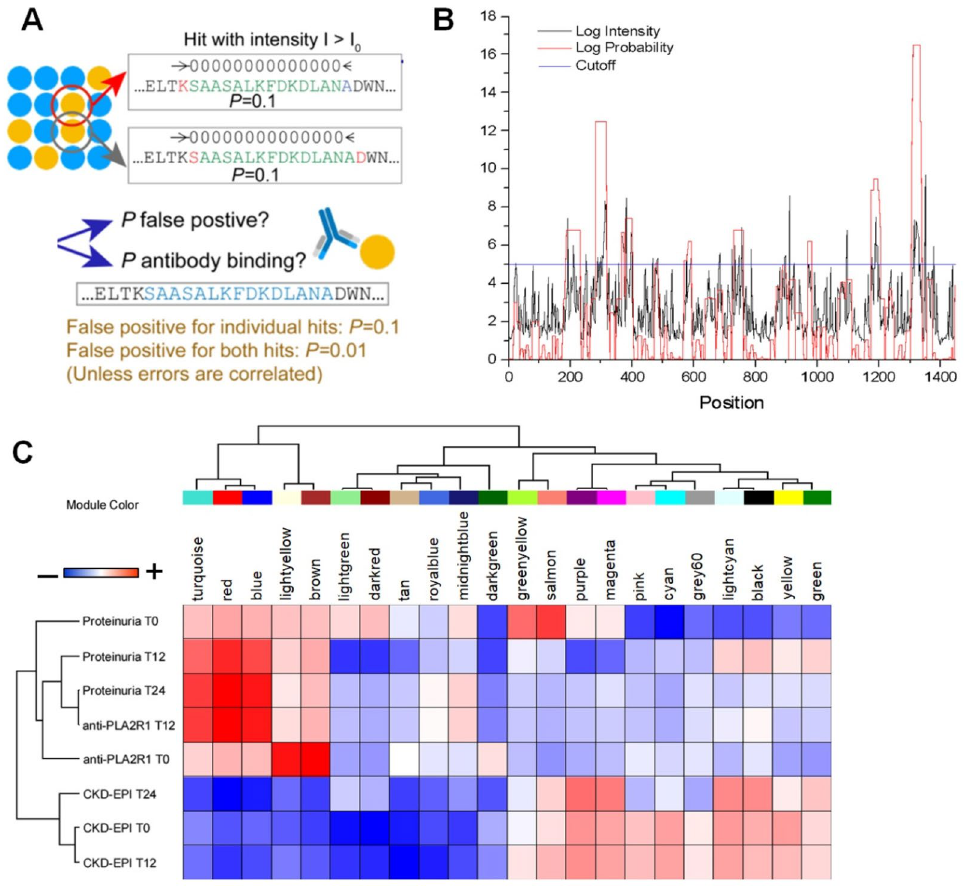
Figure 1. Method validation. ( A ) Illustration of the S-PIE underlying principle. Let P be the probability that a peptide with a fluorescence intensity larger than some threshold (I0) is a false positive. Then for two consecutive peptides the probability of both being false positive is equal to P^2. The same holds for longer stretches, which enable the identification of most probable epitopes. ( B ) Two-dimensional plot of peptides fluorescence intensity and their S-PIE analysis. ( C ) Heatmap showing the module-trait weighted relationships between the identified modules in Whole proteome peptide discovery array and the trait indicator of samples. The color scale on the top shows a module-trait relationship from − 1 (blue) to 1 (red), where blue represents a perfect negative correlation and red a perfect positive